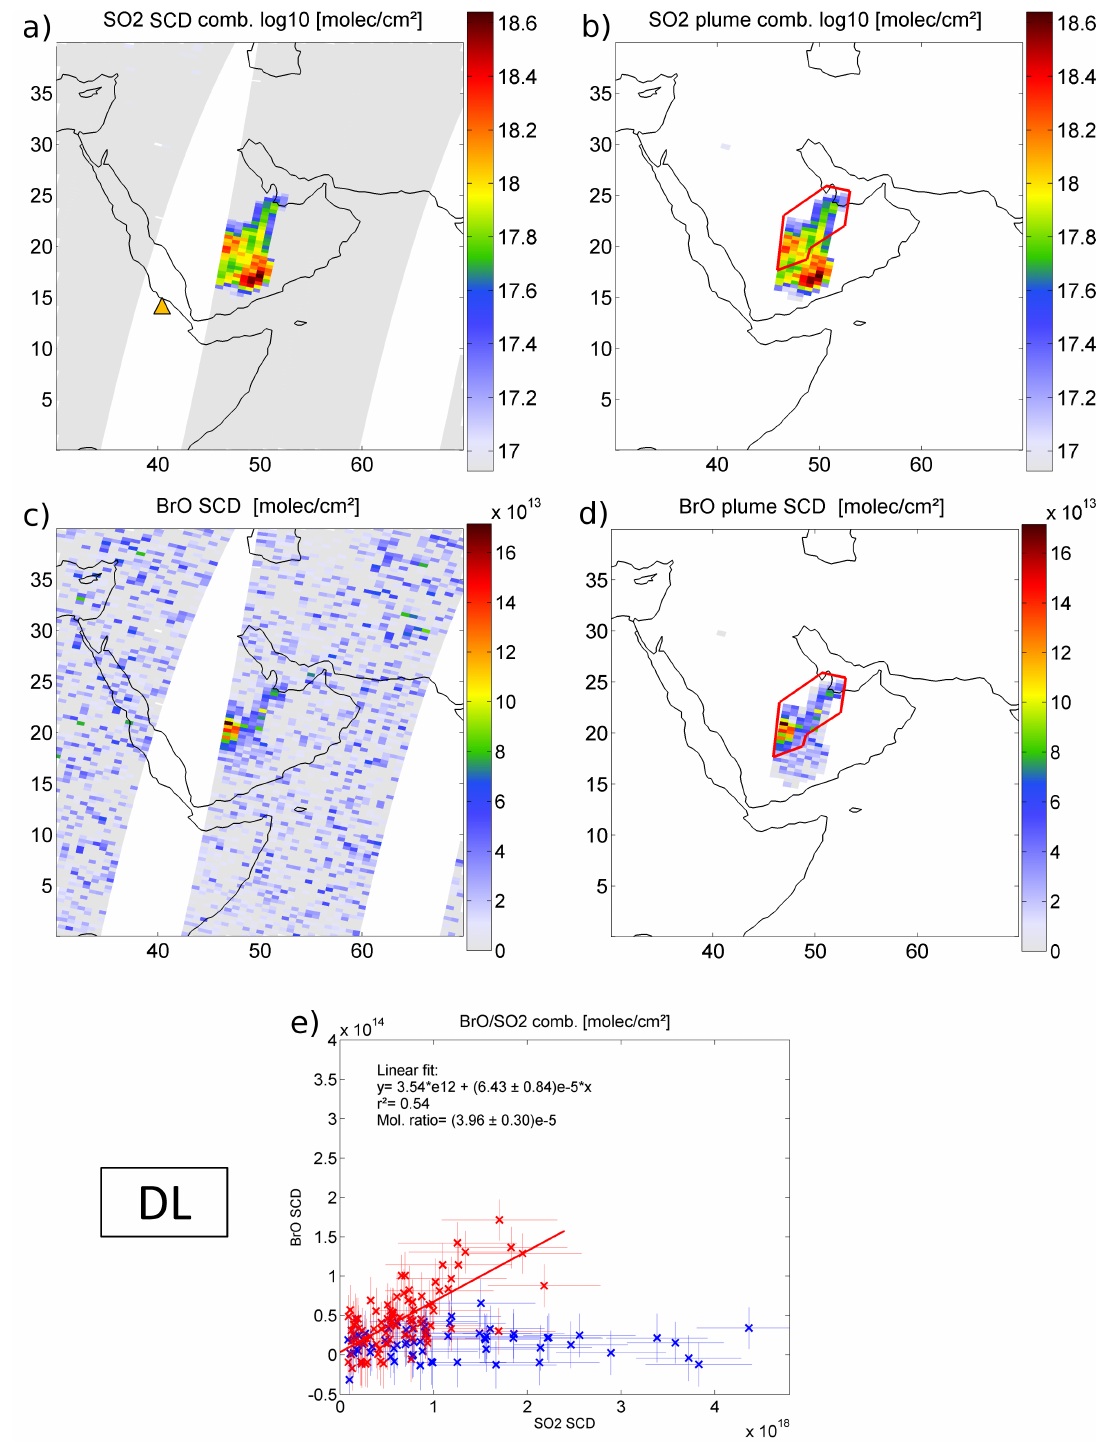
Fig. 9. GOME-2 measurements of SO 2 and BrO SCDs after the eruption of the Dalaffila volcano on 4 November 2008. The SO 2 plume is separated into two main parts and can be clearly seen in (a) the combined SO 2 retrieval (please note the logarithmic scale). In (b) , only the significantly enhanced SO 2 SCDs ∗ > 3 σ ∗ are shown. Enhanced BrO SCDs ∗ are only located in the northwestern part ( c and d ). A linear correlation can only be seen for a restriction to this area, which is indicated by the red polygon in the maps and the red crosses in the correlation plot (e) . Blue crosses represent measurements outside the restriction area. The r 2 is then 0.54 with a fitted mean BrO/SO 2 ratio ∼ 6.4 × 10 − 5